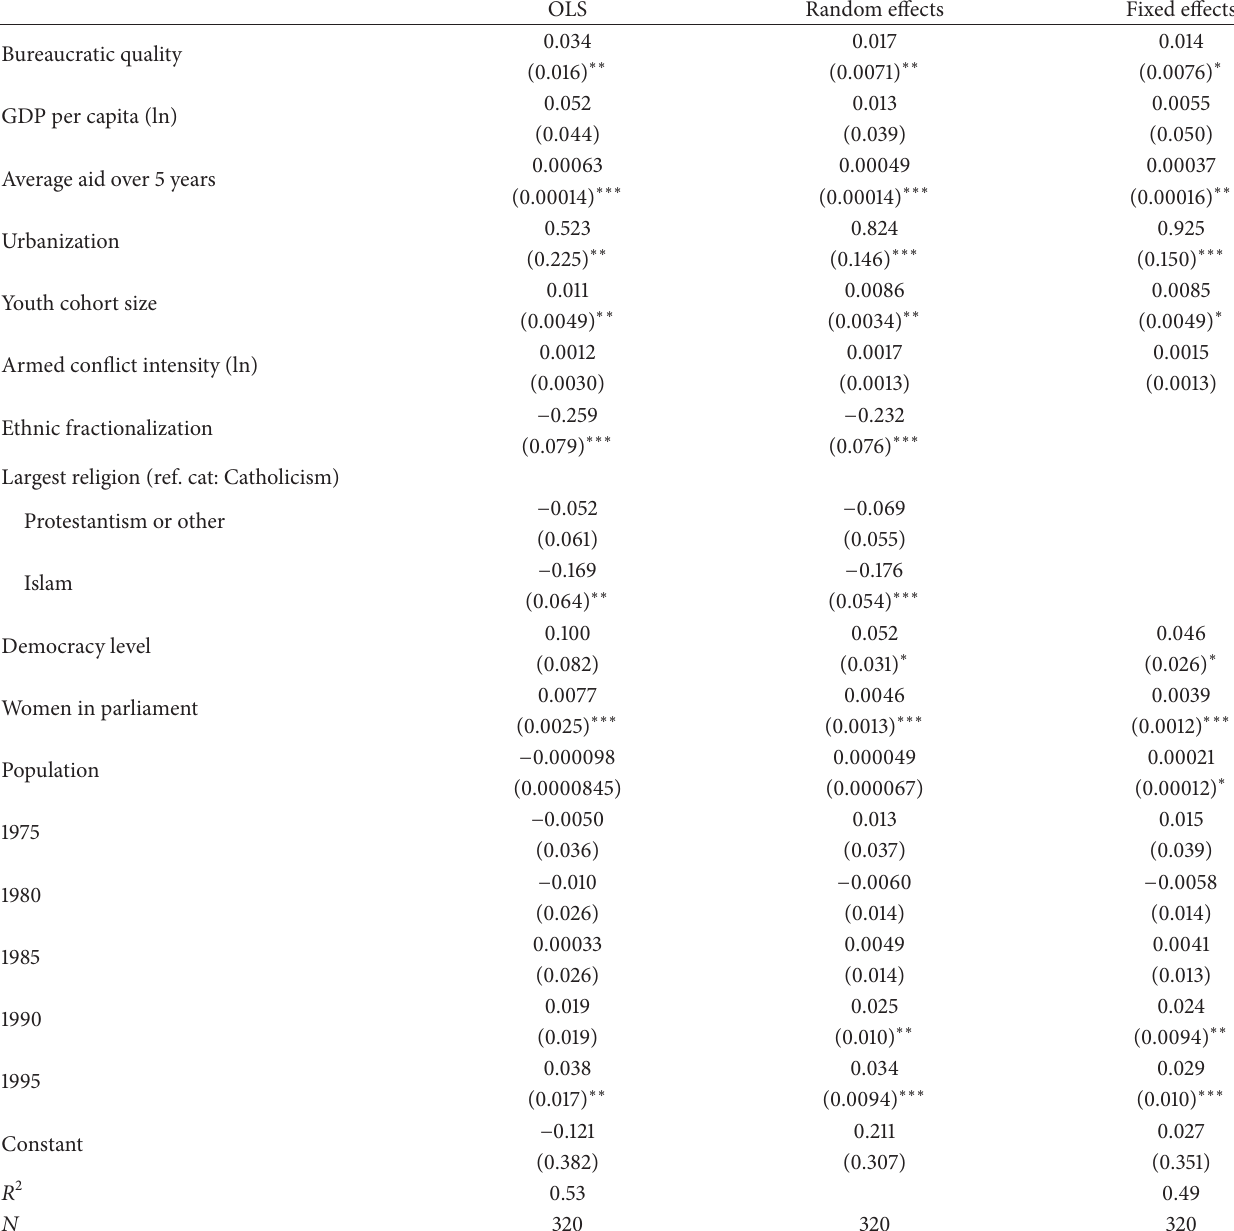
Table 5: Gender parity in secondary education attainment, developing countries: 1970–2010. Women in parliament